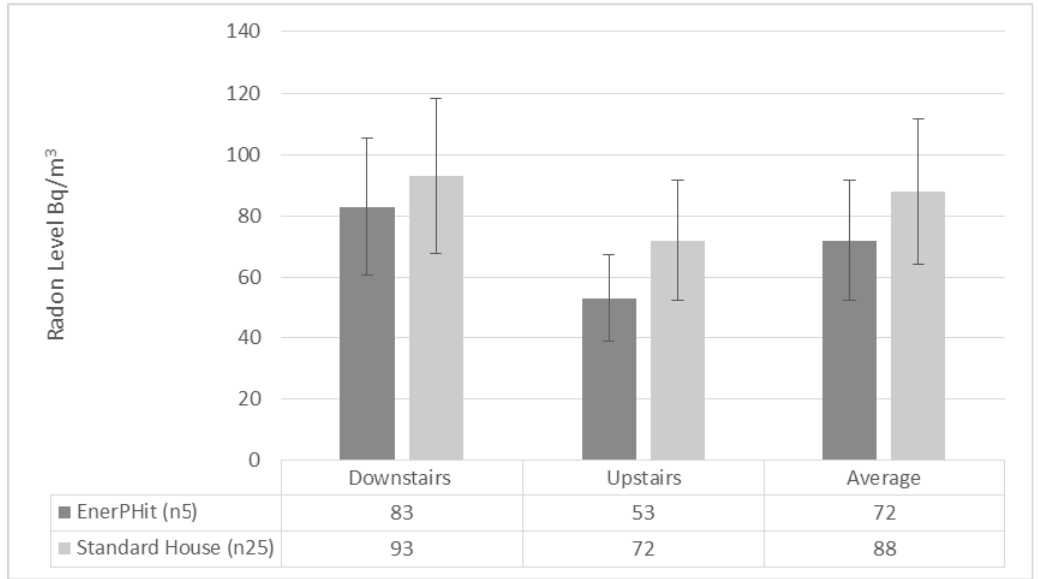
Figure 6. Passive House Retrofit standard (EnerPHit) comparison .